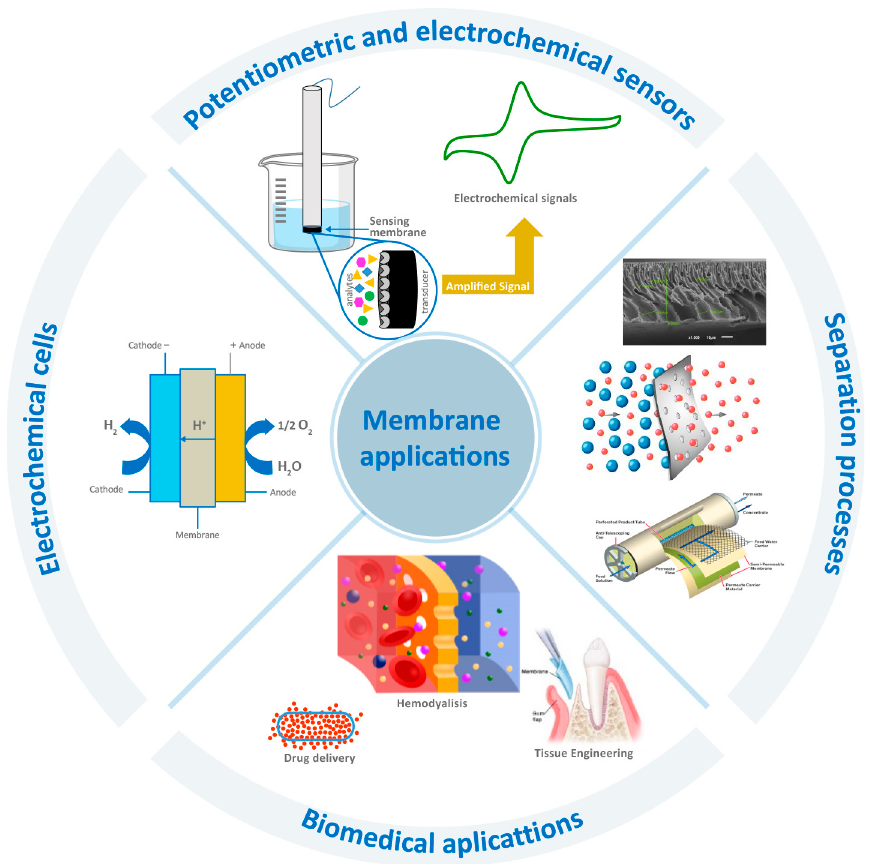
Figure 1. Application of polymeric membranes.